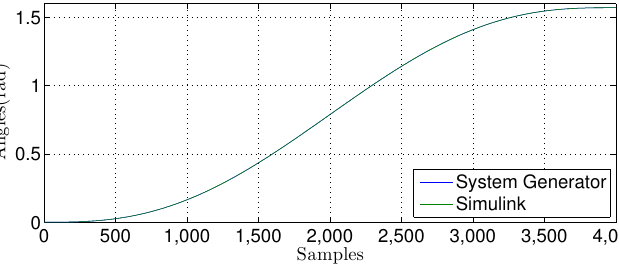
Figure 28. Comparison of the simulation results in Matlab Simulink and system generator for the linear regression technique with M = 3.